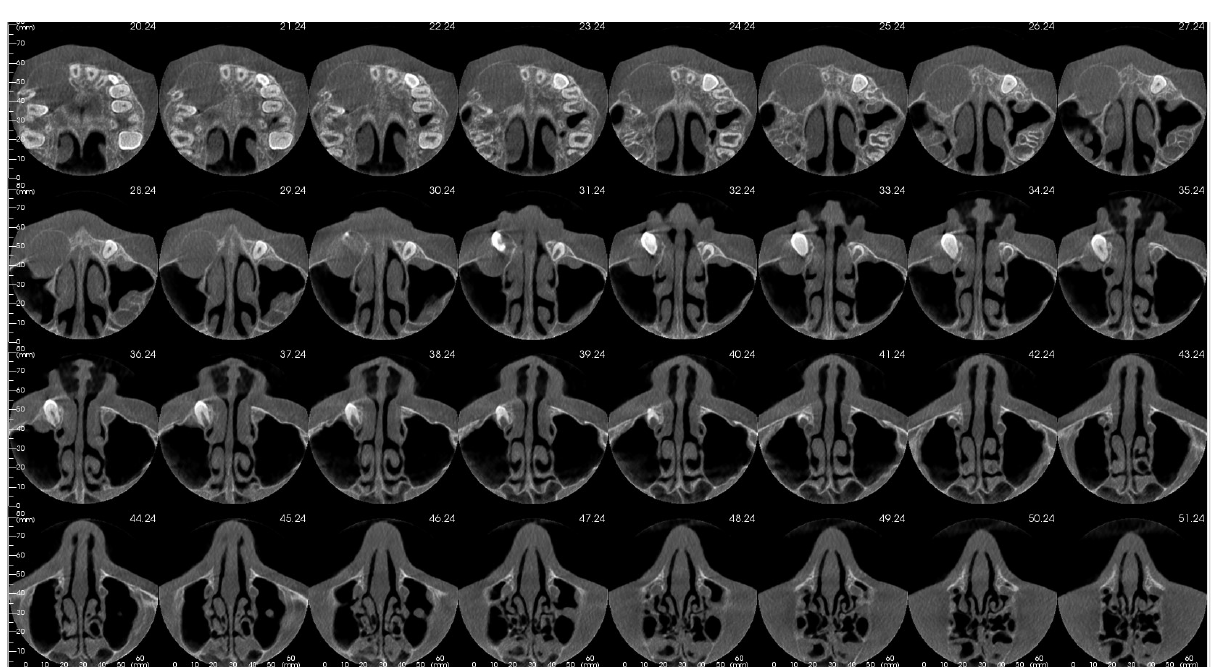
Appl. Sci. 2022 , 12 , x FOR PEER REVIEW Figure 5. CBCT before treatment—axial view. Figure 5. CBCT before treatment—axial view.